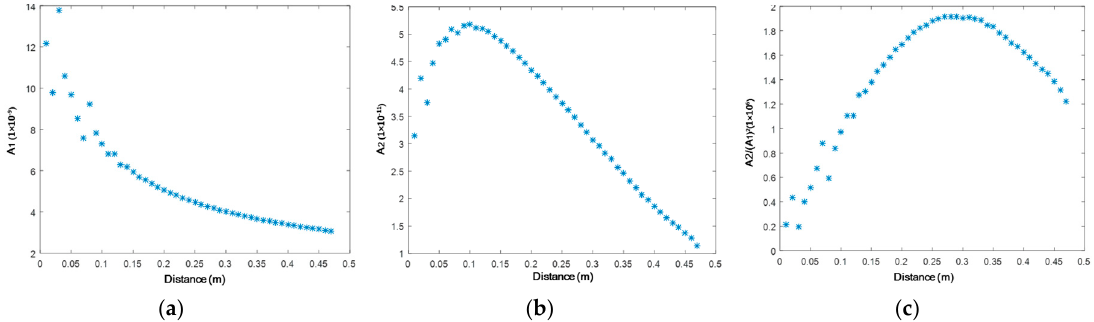
Figure 7. Magnitudes of the S 0 -S 0 mode pair (0.4 MHz mm–0.8 MHz mm) extracted through STFT in the 3-D simulation model ( a ) fundamental mode A1; ( b ) second harmonic mode A2; and ( c ) A2/(A1) 2 .